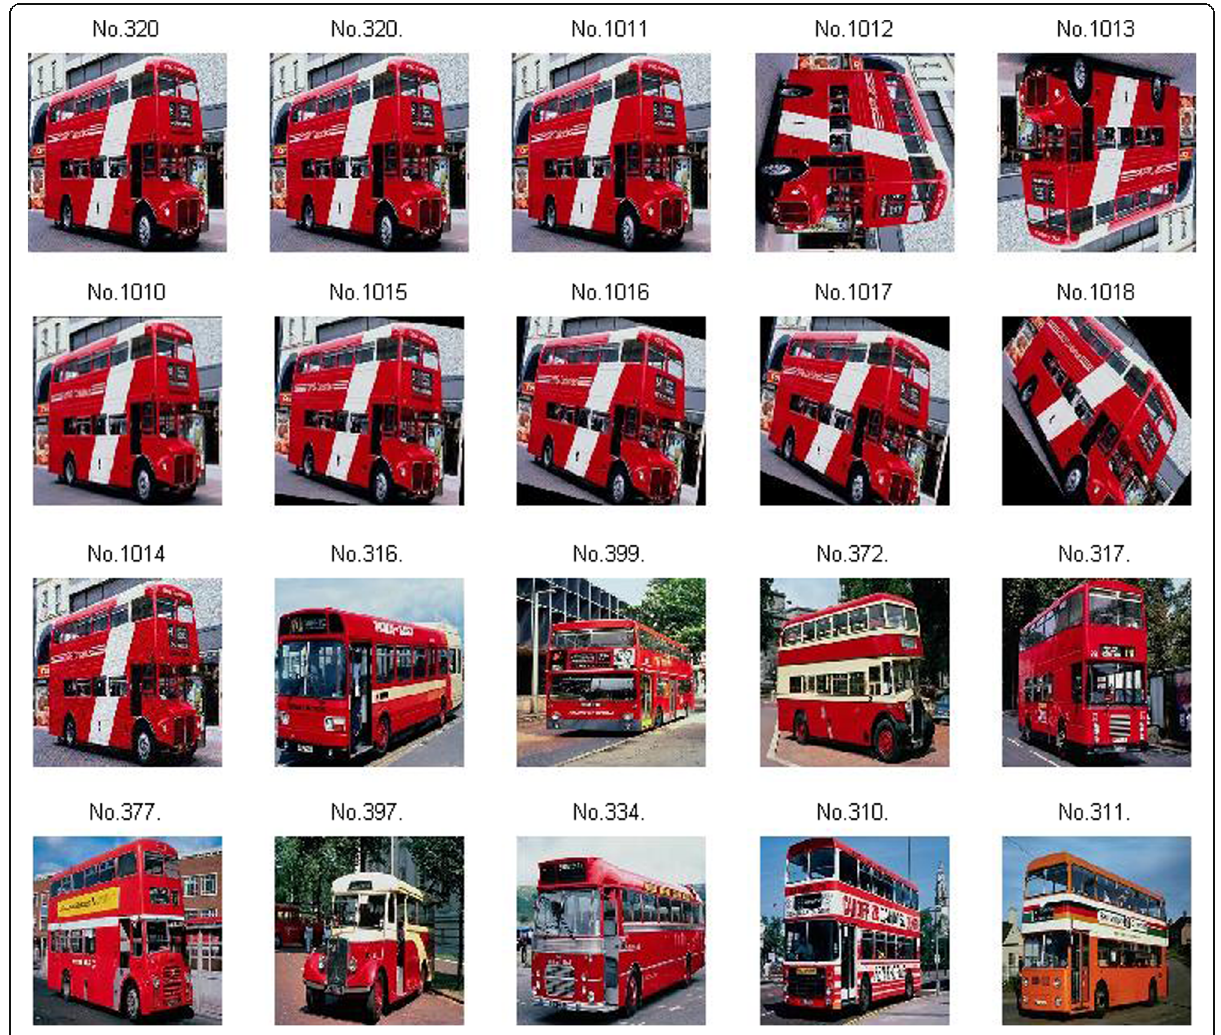
Fig. 5 Part of the retrieval results obtained using the proposed